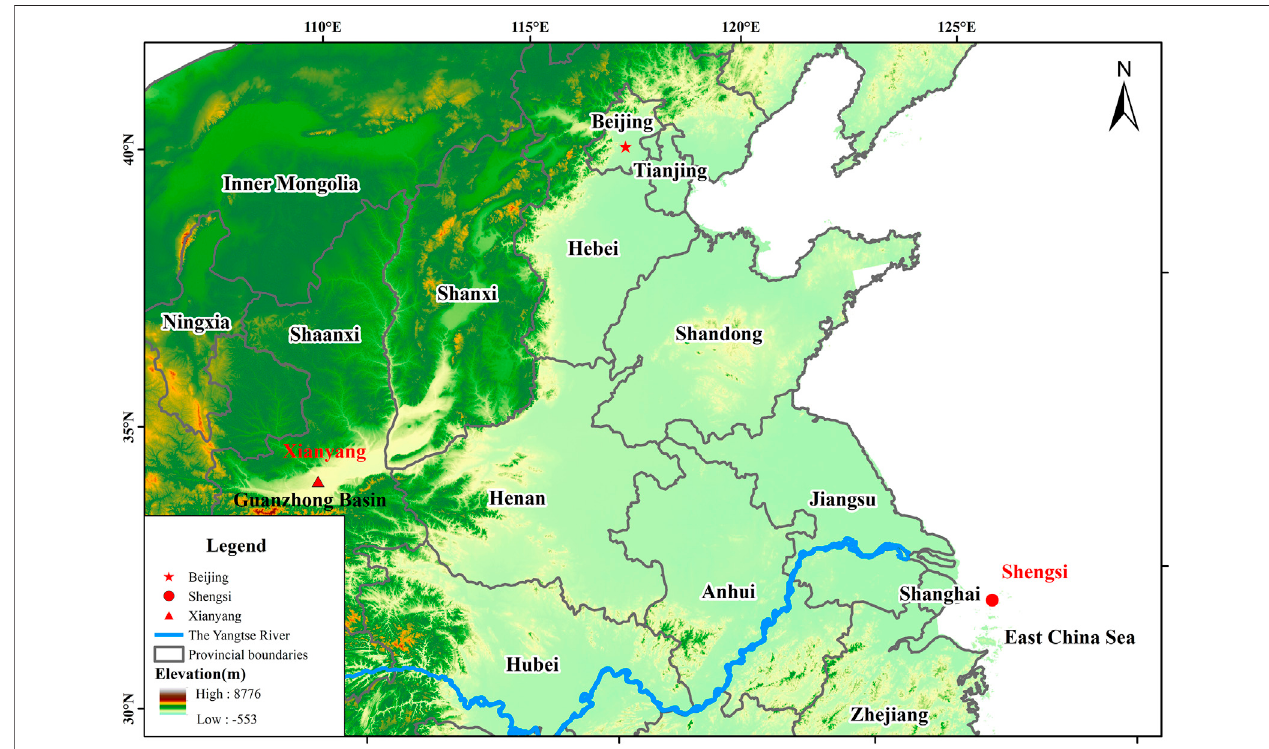
FIGURE 3 | The geographical location of shengsi and